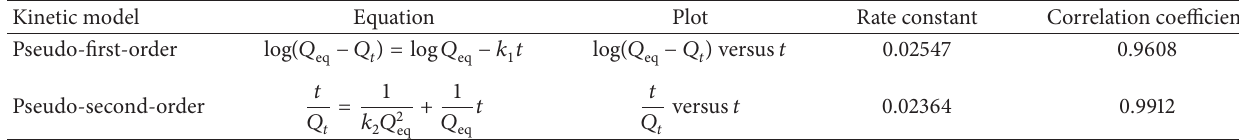
Figure 9: Fitting curve of Langmuir model (a) and Freundlich model (b) of CA4. Table 1: Kinetic models and parameters of CA4.